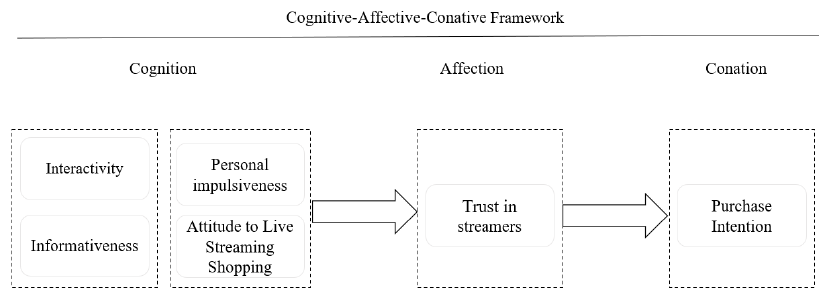
Figure 1. Conceptual